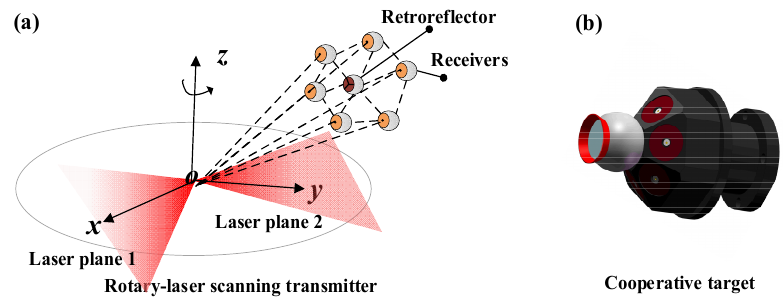
Figure 3. Measurement principle of single-station rotary-laser transmitter: ( a ) six receivers and a retroreflector with fixed position relationship; ( b ) cooperative target designed based on the principle of single station measurement and applied to guidance experiment in this paper.